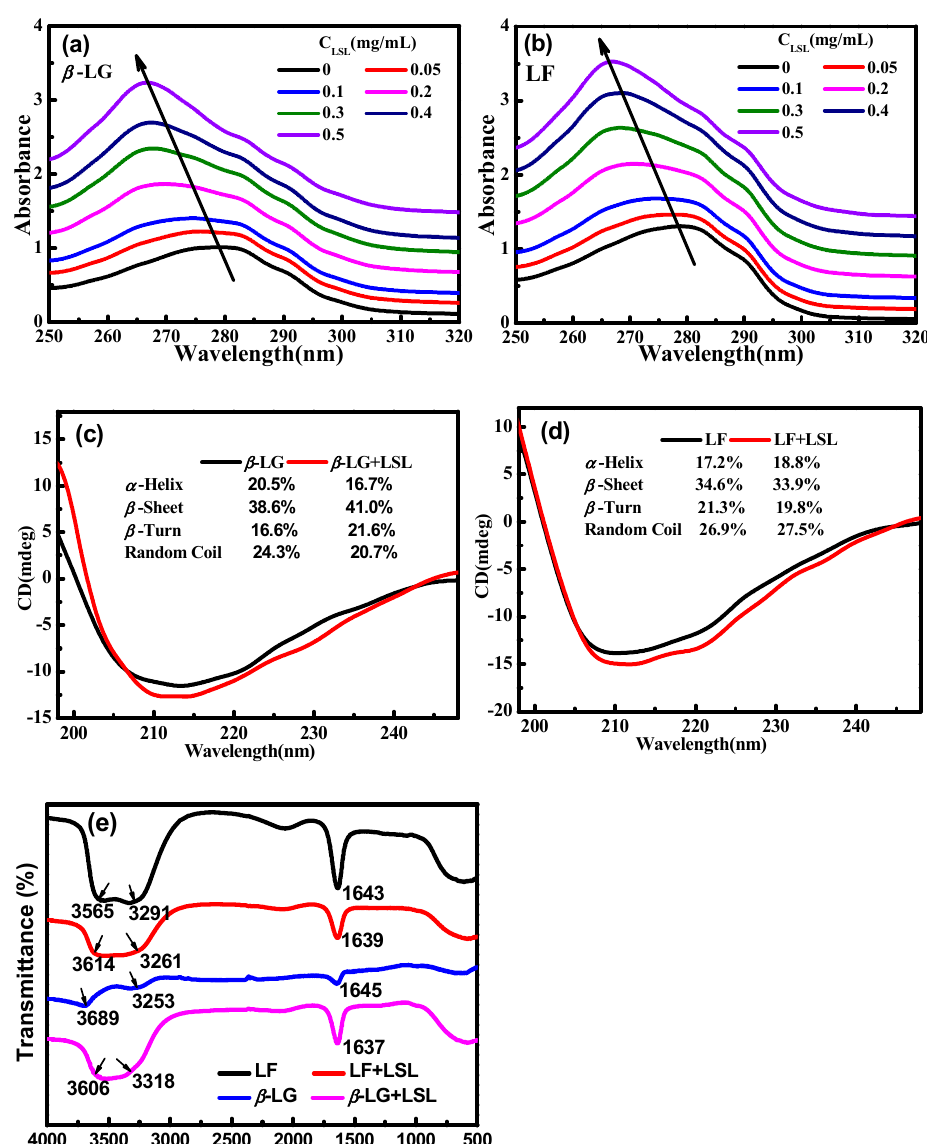
Figure 3. The UV-vis absorption spectra of β -LG ( a ) and LF ( b ) with different LSL concentrations at fixed protein concentration of 1 g/L and at 298.2 K; the CD spectra of β -LG ( c ) and LF ( d ) at fixed protein and LSL concentrations of 0.2 g/L and 1 g/L and at 298.2 K; the FT-IR spectra ( e ) at fixed protein and LSL concentrations of 1 g/L and 1 g/L and at 298.2